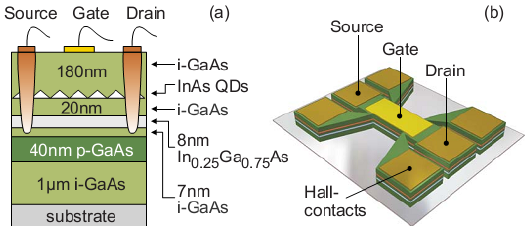
Figure 1. ( a ) Schematic cross section of the layered structure. ( b ) Sketch of the SAQD–Flash prototype. Hall-contacts were used for the transport measurements of 2DHG [12].